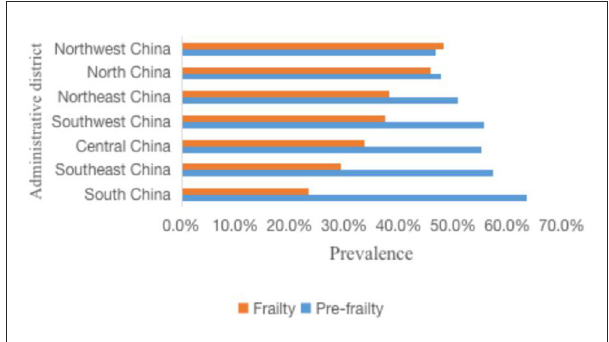
FIGURE2 Prevalence of frailty and pre-frailty in older adults with asthma in different administrative